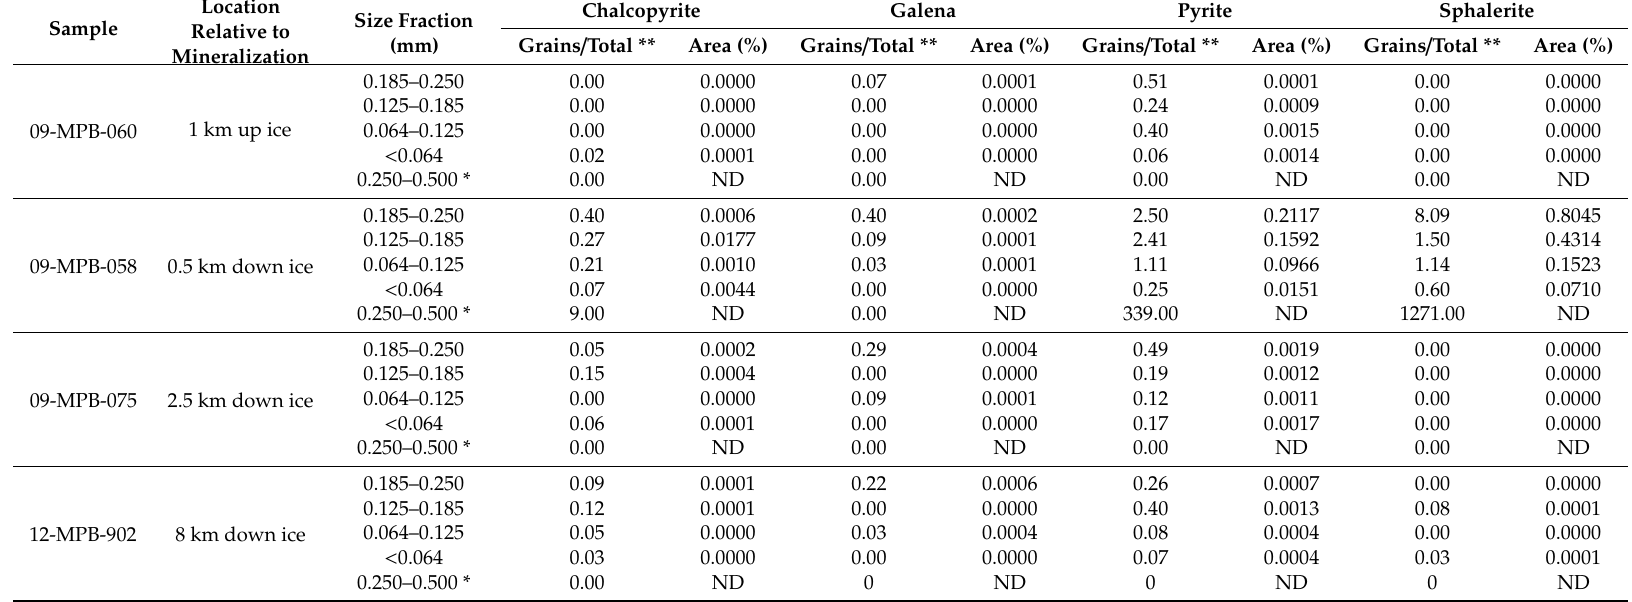
Table 3. Abundance of ore indicator minerals in four till sample up- and down ice of the Izok Lake volcanogenic massive sulfide (VMS) deposit. Mineral abundance data are reported in two ways: (1) number of indicator mineral grains per total grains, normalized to 1000 grains; (2) minerals by 2-dimensional percentage area they take up on the polished mount surface. Values for 0.25–0.50 µ m material are from the heavy mineral fraction of the same sample obtained by visual grain picking that have been normalized to a 10 kg of sample mass (data from Hicken et al.